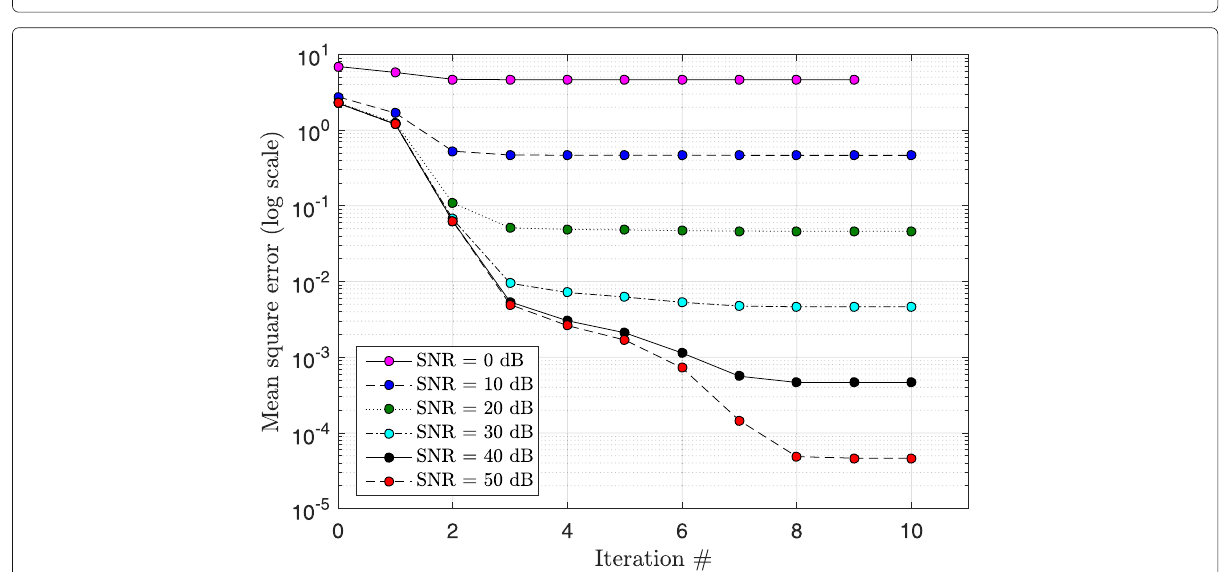
(cid:22) N − 1 | x ( t ) − s ( ˆ θ , t ) | 2 as a function of the number of iterations of the trust-region-reflective algorithm n n n = 0 N